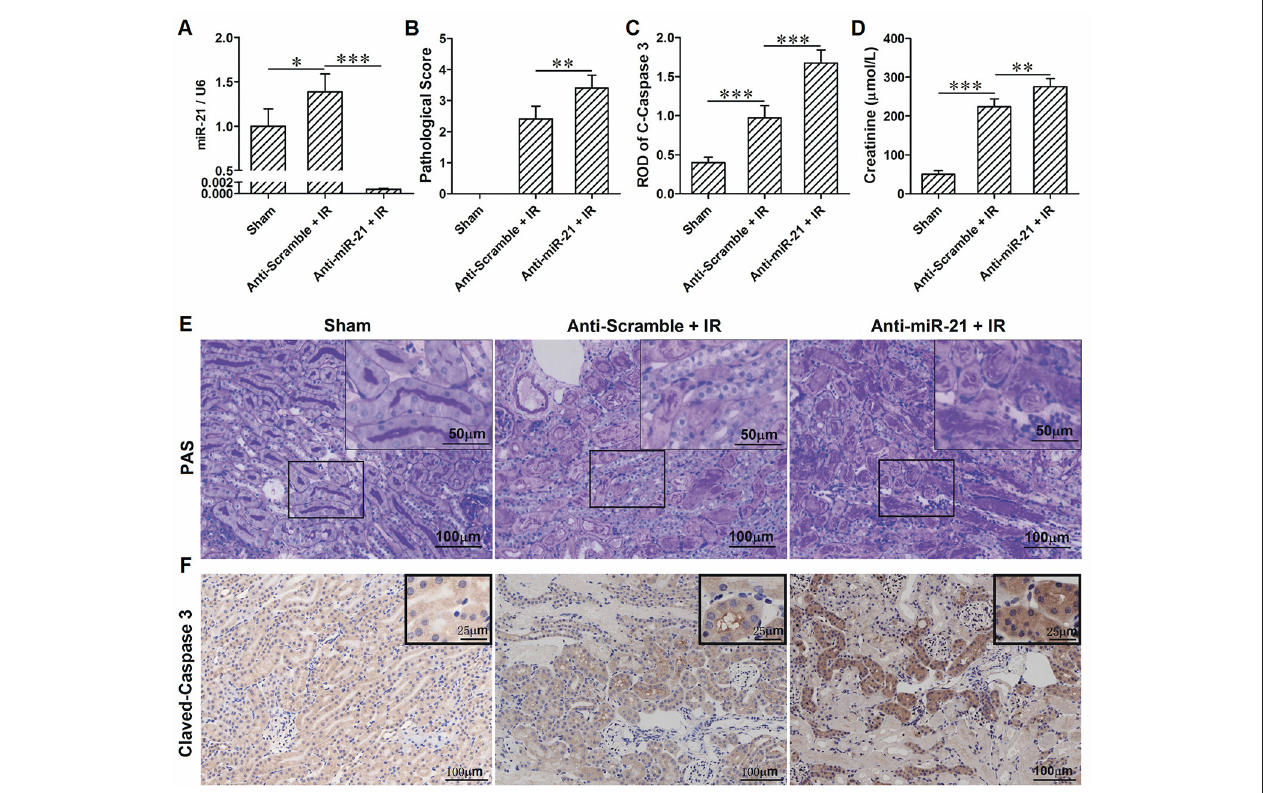
FIGURE 1 | IR induces up-regulation of miR-21 in kidney and knockdown of miR-21 aggravates renal IRI. (A) Expression level of miR-21 in the kidney was higher in the IR group compared with sham group. Injection of LNA-modified anti-miR-21 (10 mg/kg) through the tail vein 1h before kidney IR surgery significantly blocked expression of miR-21. (B) PAS staining was performed to access the injury of the kidney. IR-induced kidney damage is more evident in the miR-21 interfered animals. (C) immunohistochemical analysis of Cleaved-Caspase 3 was performed to access the apoptosis of the tubular epithelia. Anti-miR-21 exacerbated IR-caused epithelia apoptosis. (D) Level of creatinine in the serum was measured to evaluate renal function. Anti-miR-21 aggravated the decline of renal function. (E) Typical visual field of PAS staining. (F) Typical visual field of immunohistochemical staining of Cleaved-Caspase 3. * P < 0.05, ** P < 0.01, *** < 0.001, n =